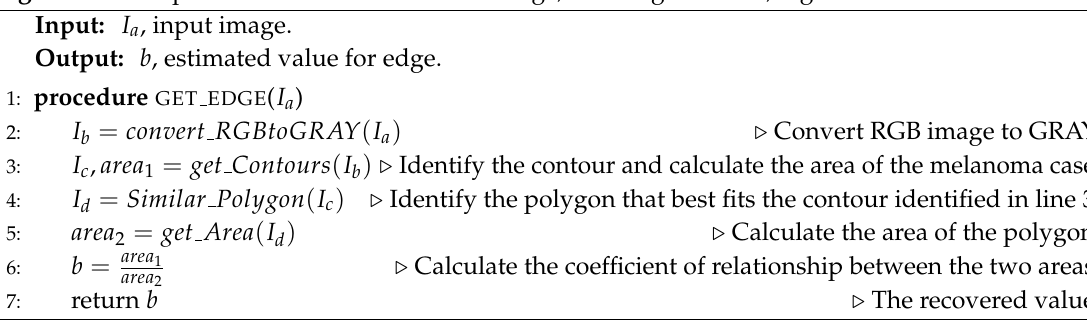
Algorithm 6 Proposed method to evaluate the edge, showing lines 1–7, Figure